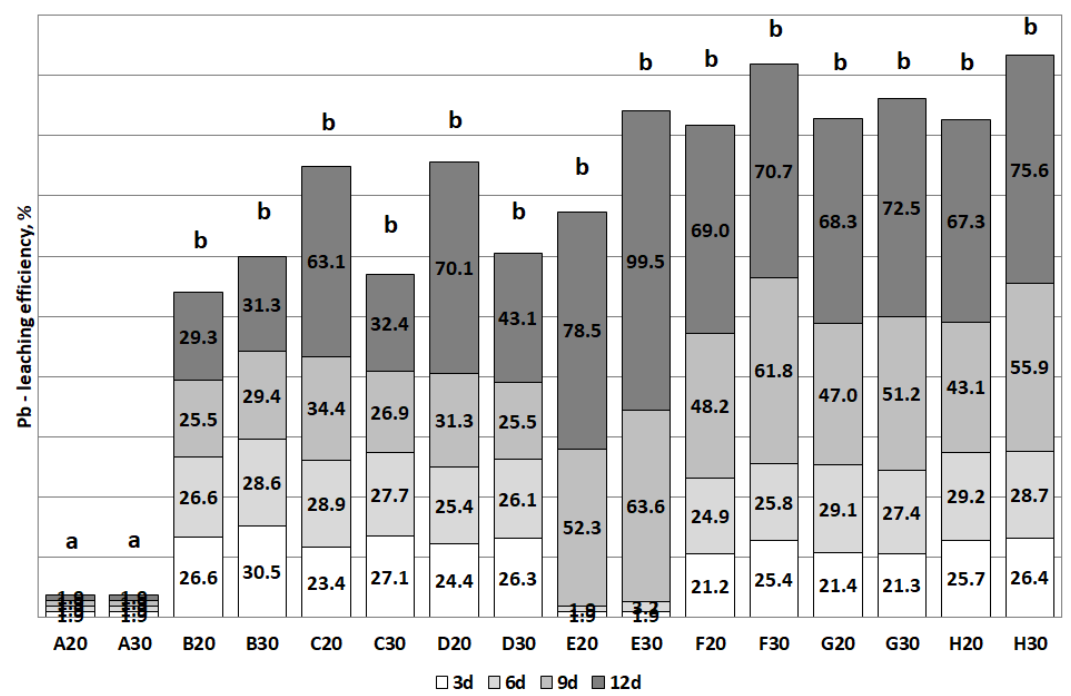
Figure 15. Bioleaching efficiency of Pb during the experiment (Statistical groups a and b ).